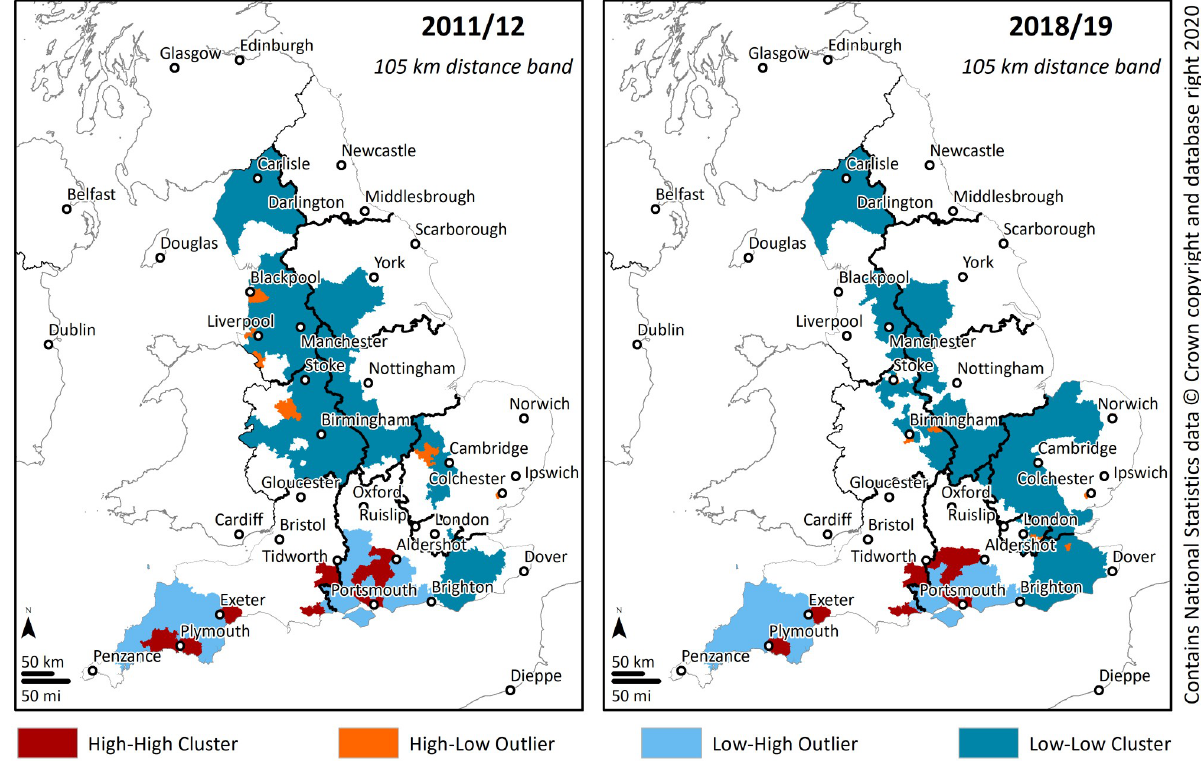
Fig 3. Clusters and outliers of the density of SCPP pupils (105 km distance